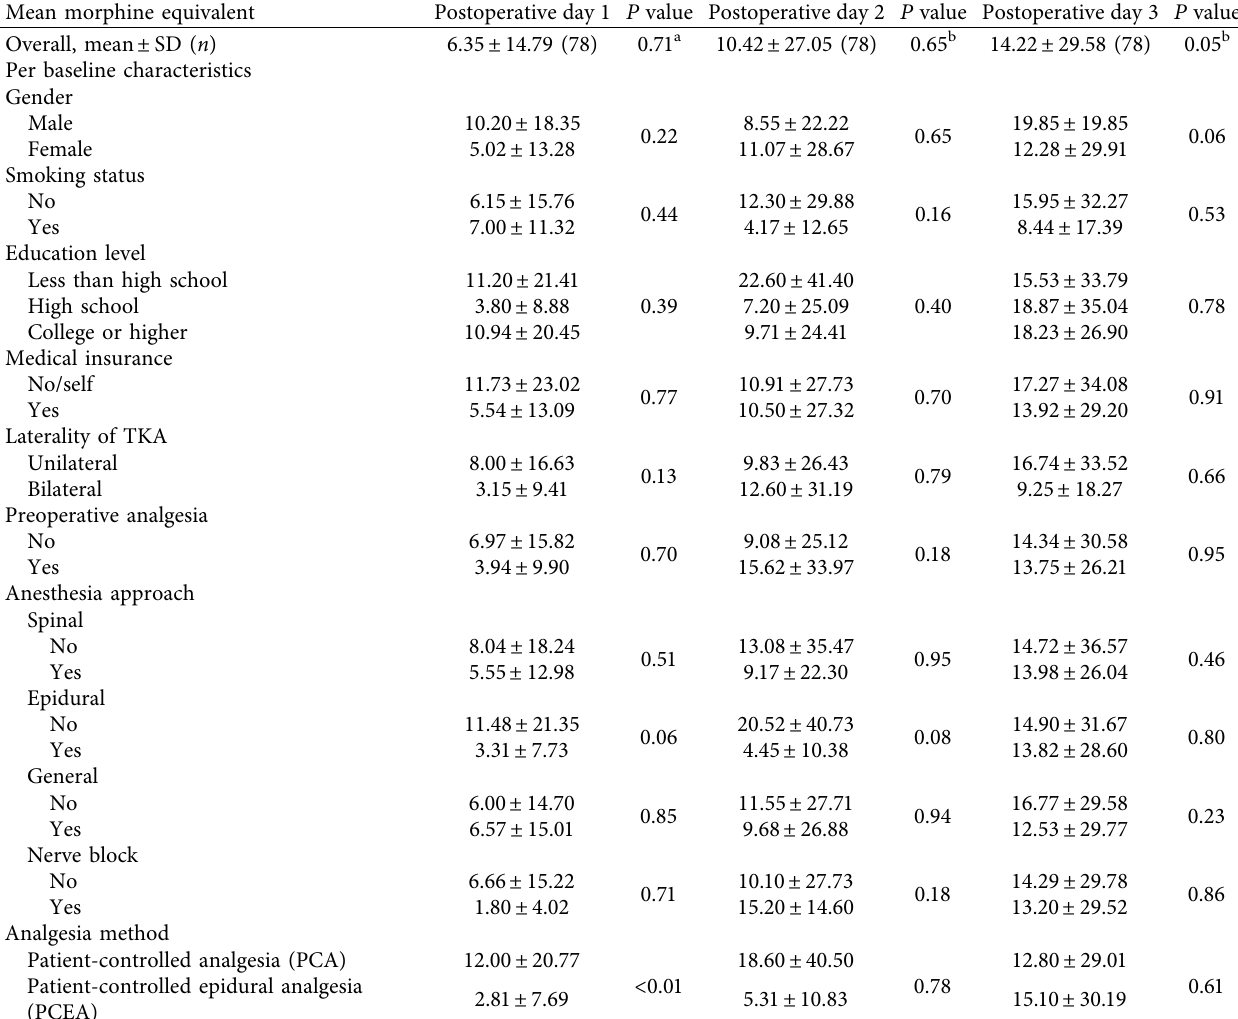
Table 3: The overall and stratified means and standard deviation (SD) of the daily morphine equivalent administered on the postoperative days one, two, and